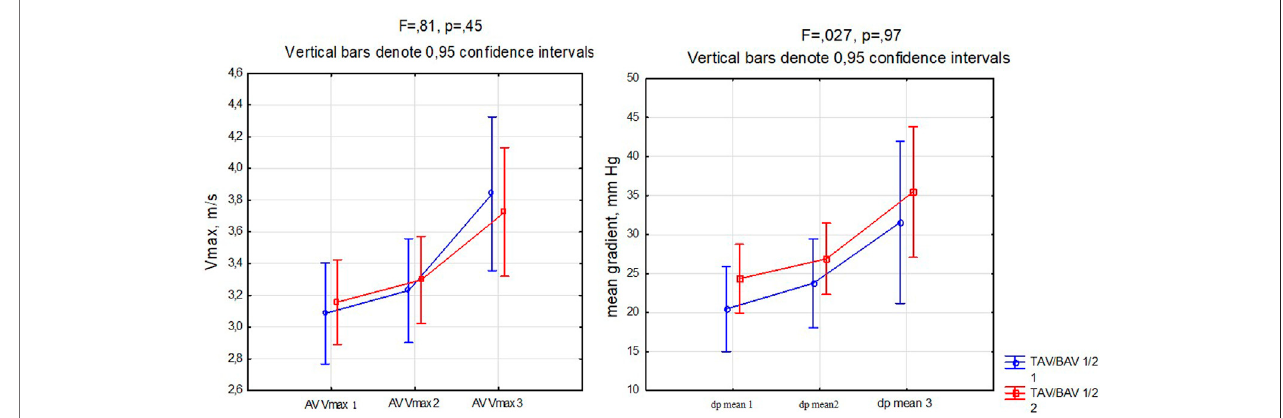
FIGURE 3 | V max and mean gradient dynamics by groups during follow up.